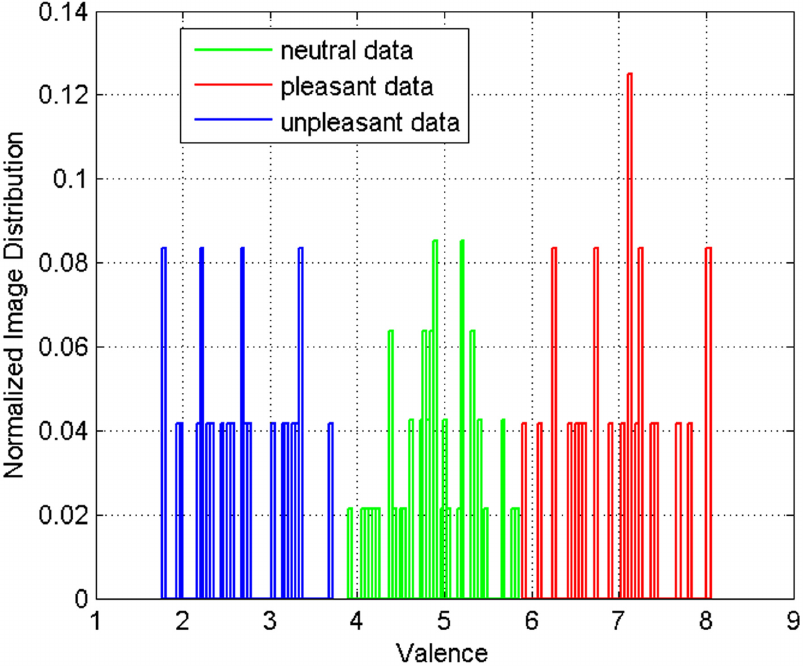
Fig 3. Distribution of images across the valence range in each class of unpleasant, neutral, and